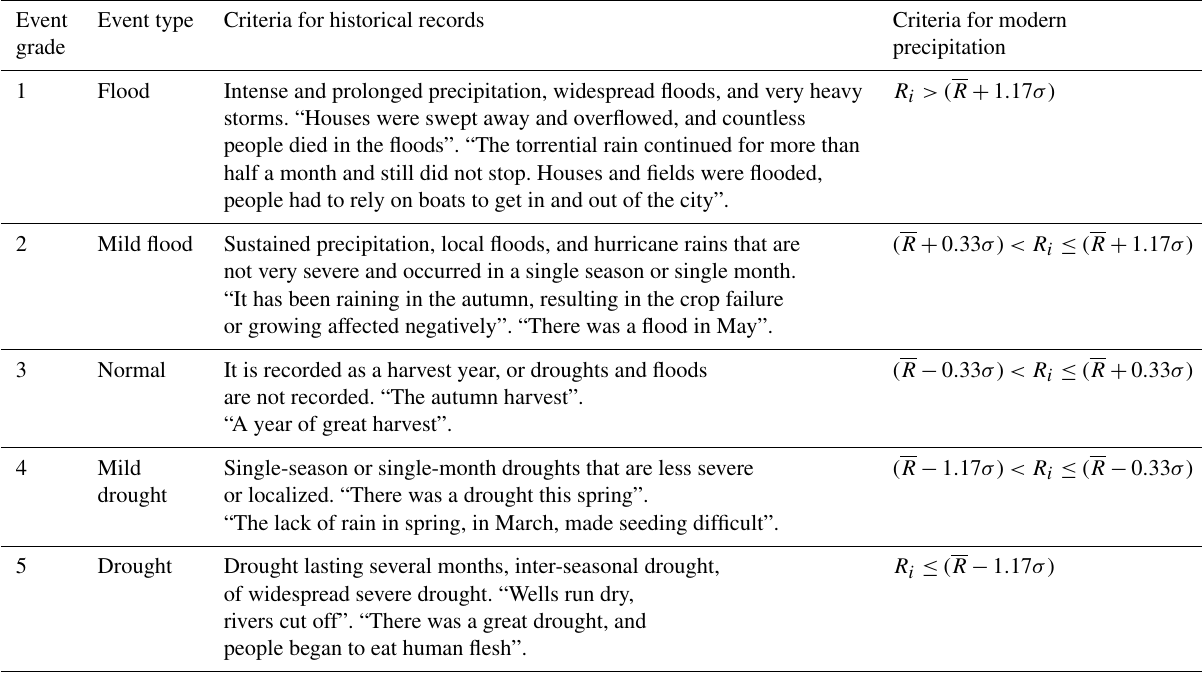
Table 1. Criteria for classifying droughts and floods in the HRB and their typical descriptions in historical sources as well as criteria for grading precipitation in modern time.